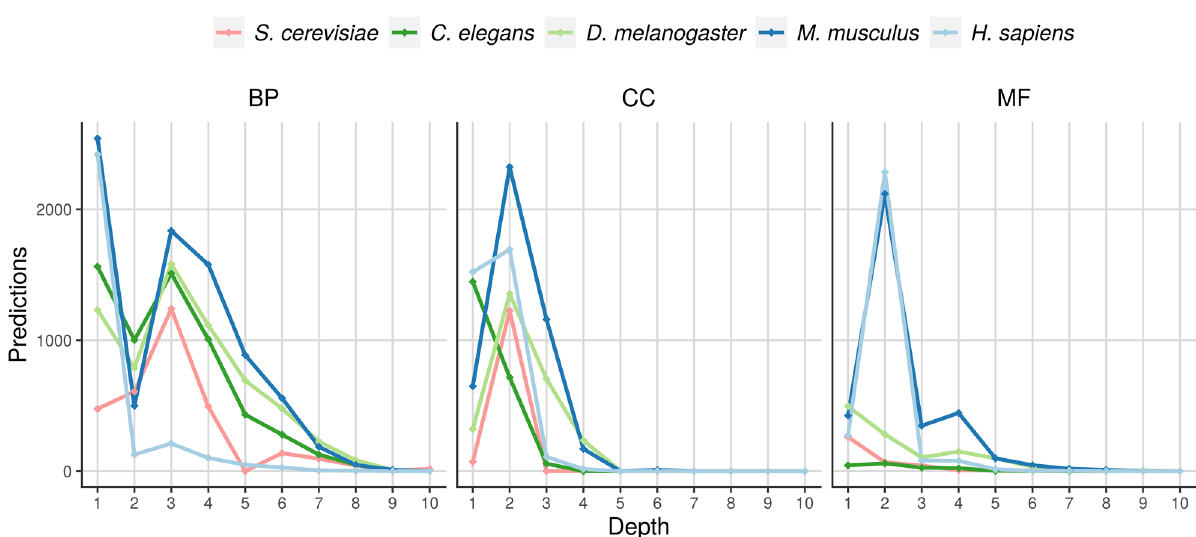
Figure 7. Predictions by depth in the ontology. Each graph corresponds to a different ontology and each organism is shown in a different color. The depth in the ontology is depicted in the x axis and the number of predicted associations above the classification threshold is depicted in the y